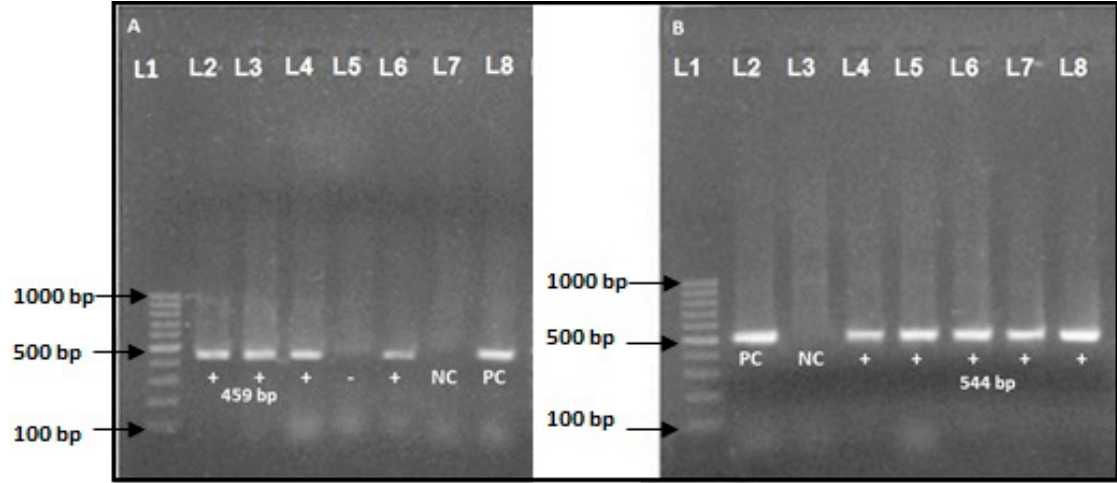
CTX-M and bla TEM genes in E. coli .